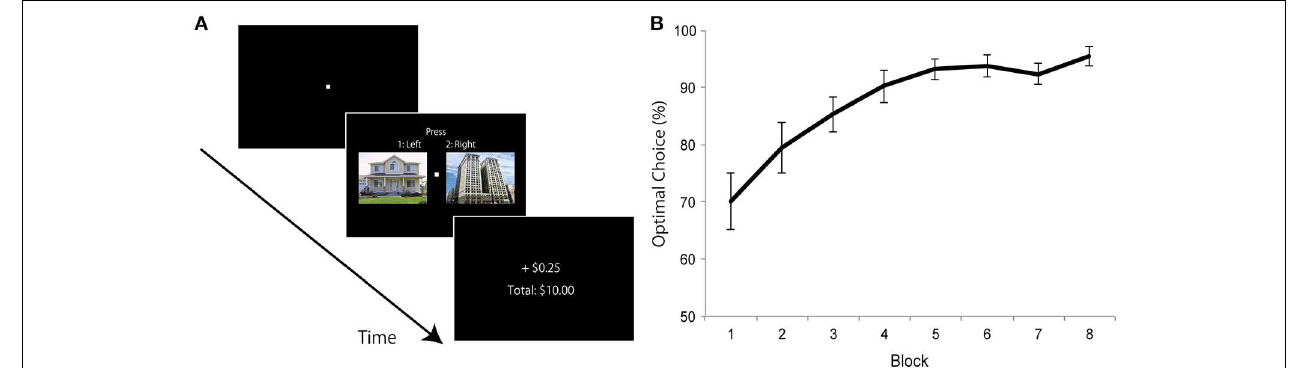
images (e.g., “house”) was associated with a high probability (0.8) and the other category (e.g., “building”) was associated with a low probability (0.2) of winning reward. (B) Average probability of choosing the optimal image in each block. Error bars denotes standard error of the